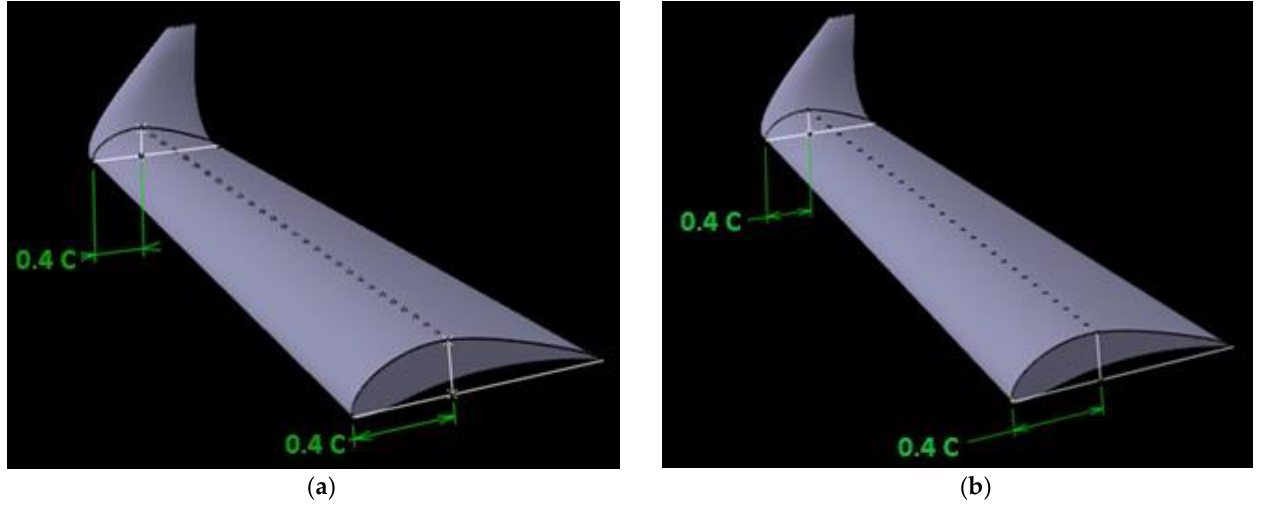
Figure 3. CAD design of the wing with ( a ) bumps with a diameter of 2.5 mm and ( b ) dimples with a diameter of 2.5 mm.